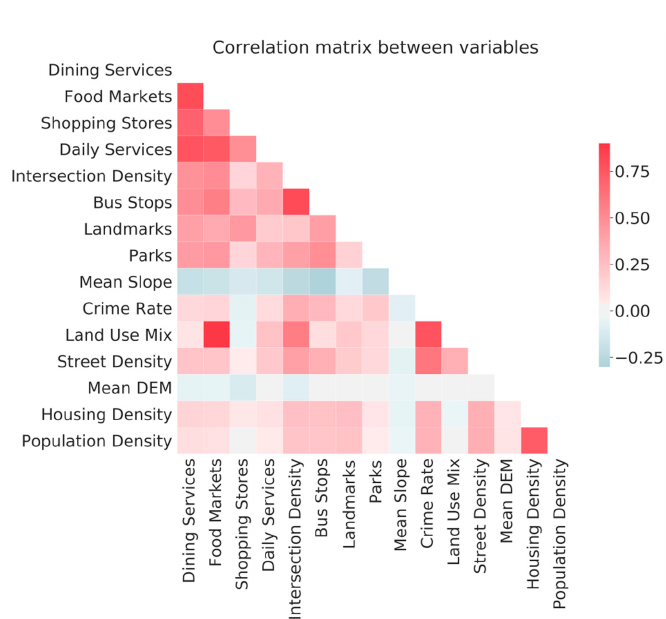
Figure 3. Pearson’s correlation coefficient matrix for variables derived from online open data.